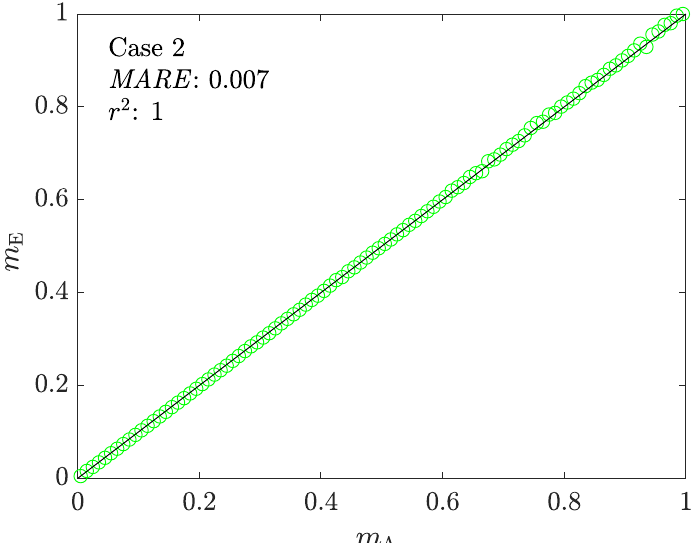
Figure 11. The correlation between m A and m E in Case